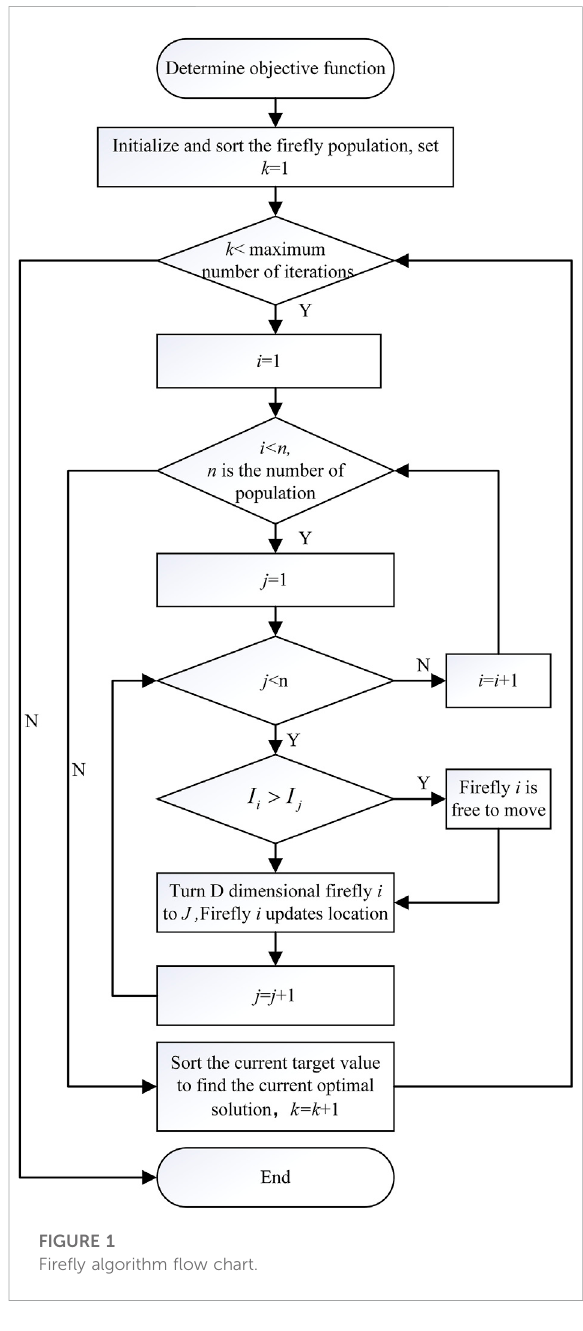
FIGURE 1 Fire fl y algorithm fl ow